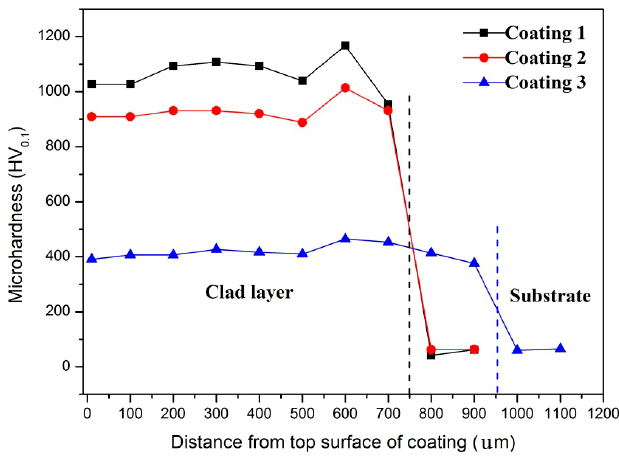
Figure 12. Variations of microhardness along the depth of coatings.